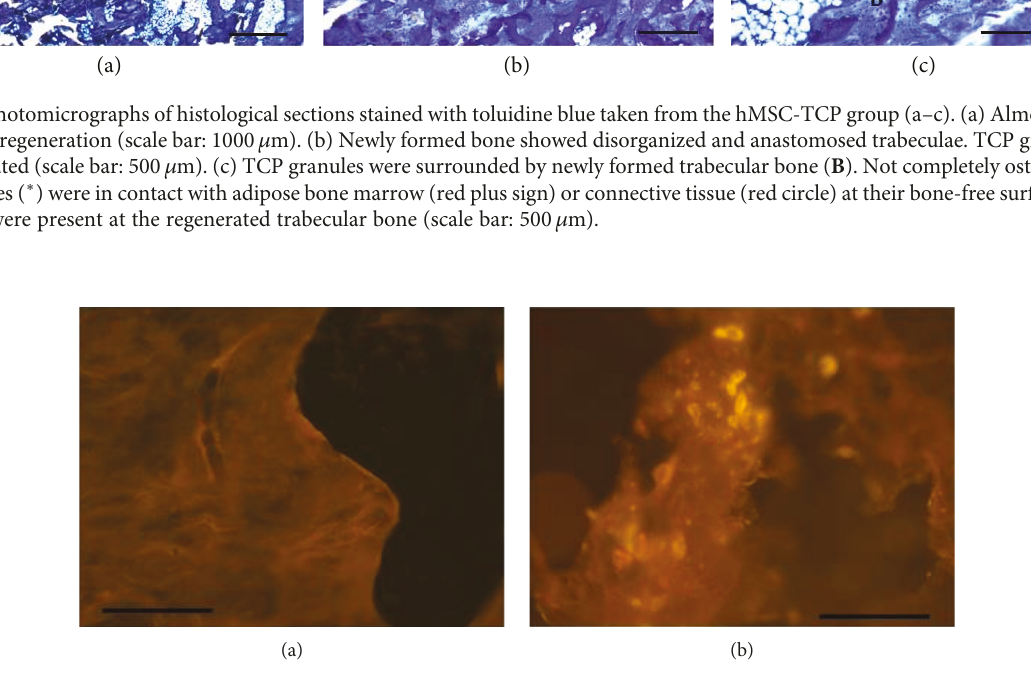
Figure 7: Fluorescent images of the TCP group (a) and the hMSC-TCP group (b) (scale bar: 150 μ m). (a) No immuno fl uorescence was detected. (b) Speci fi c immuno fl uorescence detection of survival hMSC at the critical-size bone defect in inmunocompetent rabbit 12 weeks after